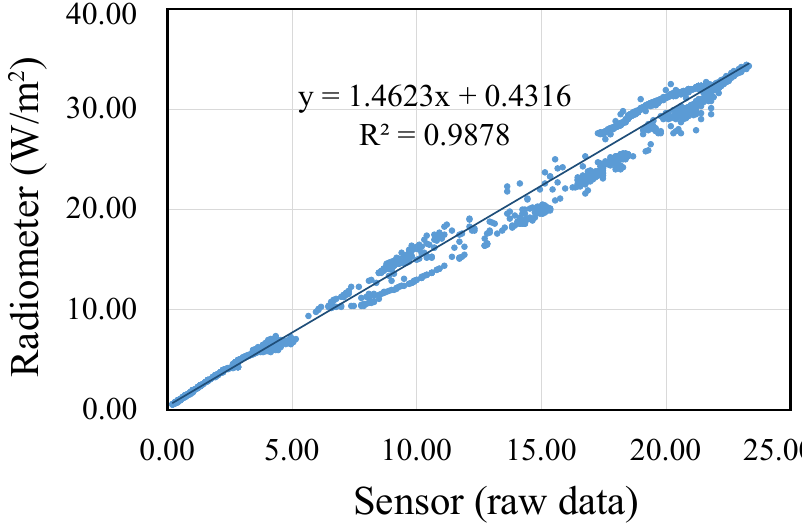
Figure 5. Relationship between the sensor measures and the pattern provided by the radiometer.